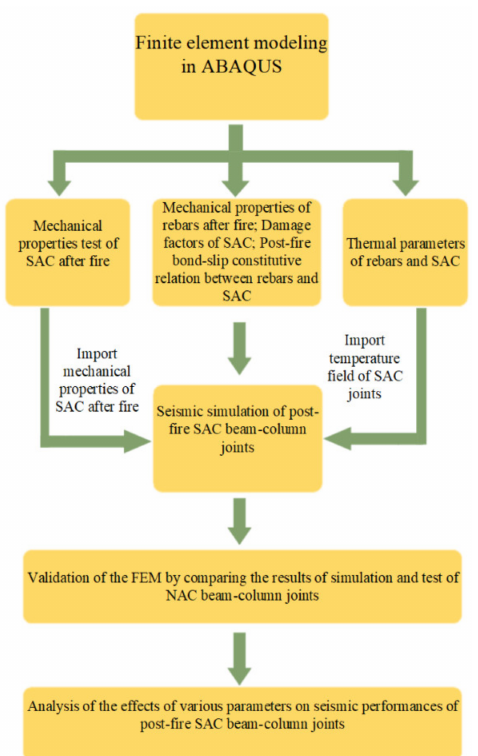
Figure 1. Analysis procedure for seismic performance of post-fire beam-column